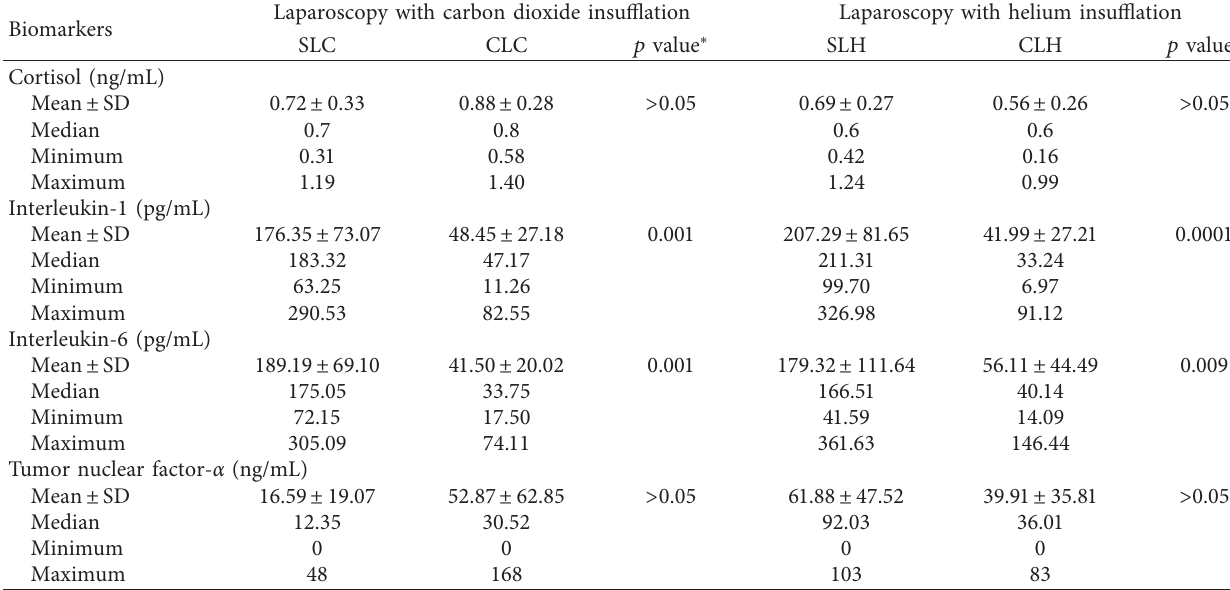
Table 1: Serum levels of biomarkers of sepsis in rats after 24h of laparoscopic cecal ligation and puncture (CLP) induced sepsis assisted by either carbon dioxide or helium